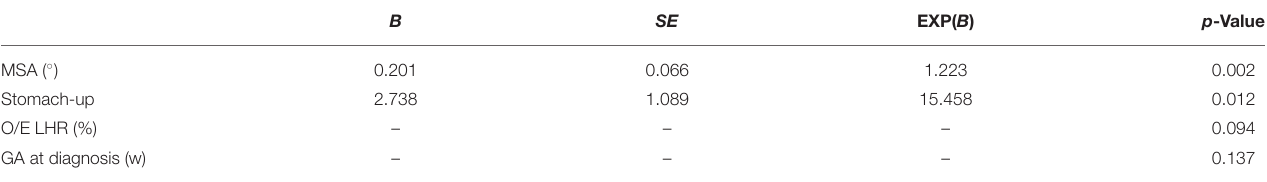
TABLE 3 | Multiple logistic regression analysis to identify independent risk factors of severity with left CDH diagnosed prenatally.